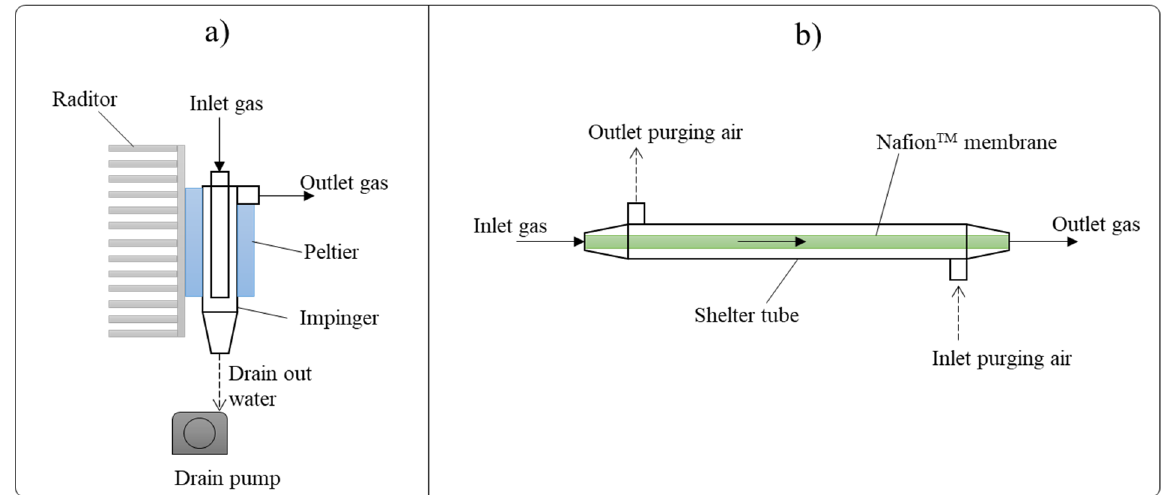
Figure 1. Schematic diagrams of a cooler ( a ) and a Nafion ™ dryer ( b ).